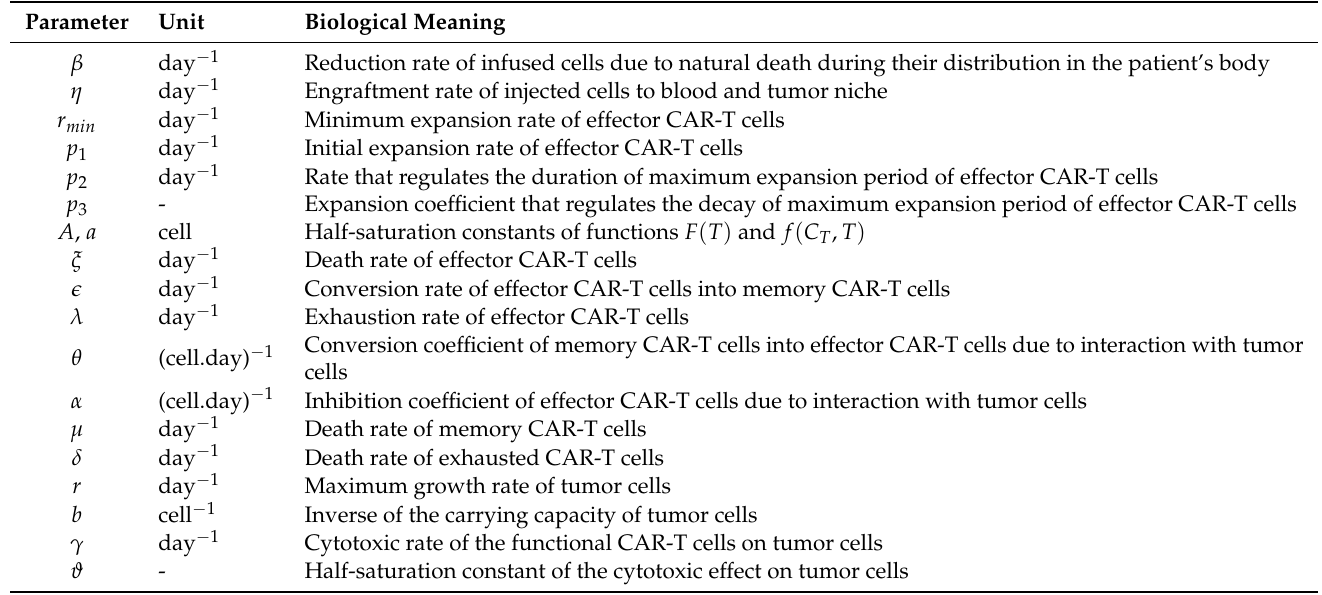
Table 1. Model parameters with their units and biological